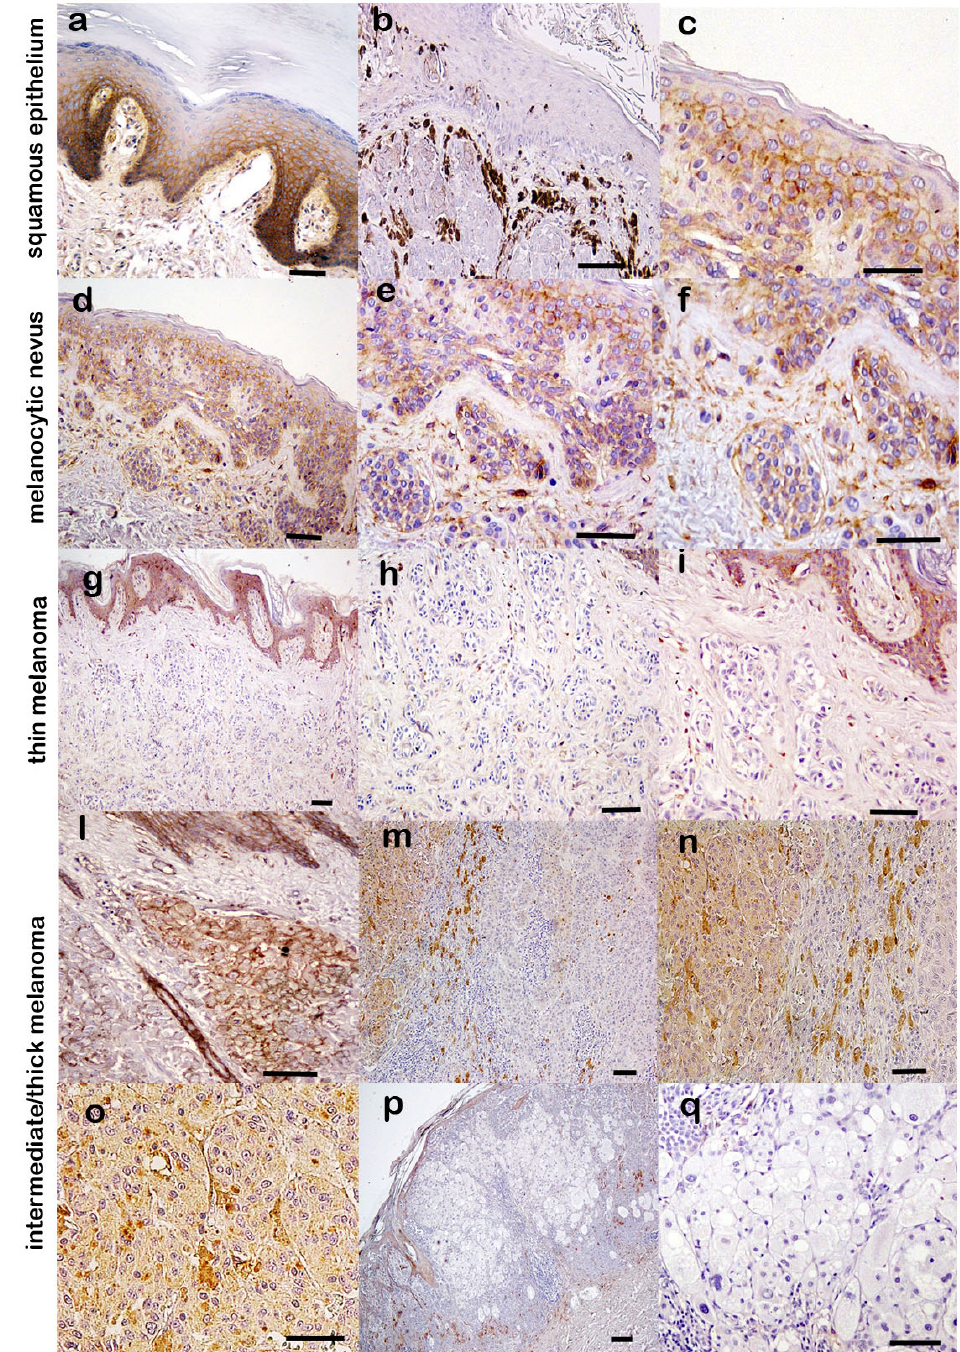
Figure 2. CD9 expression in melanocytic nevi and melanomas. ( a – c ) CD9 staining in the squamous epithelium, ( b ) CD9 staining was often not conserved in the epithelium from which the tumors arose. ( d – f ) Homogeneous CD9 staining in melanocytic nevus. ( g – i ) Loss of CD9 expression in thin melanoma. ( l – o ) CD9 staining was often re-expressed in small clusters of tumor melanocytic cells in intermediate and thick melanomas. ( p , q ) Thick melanoma negative for CD9. (immuno-peroxidase, scale bars 50 µ